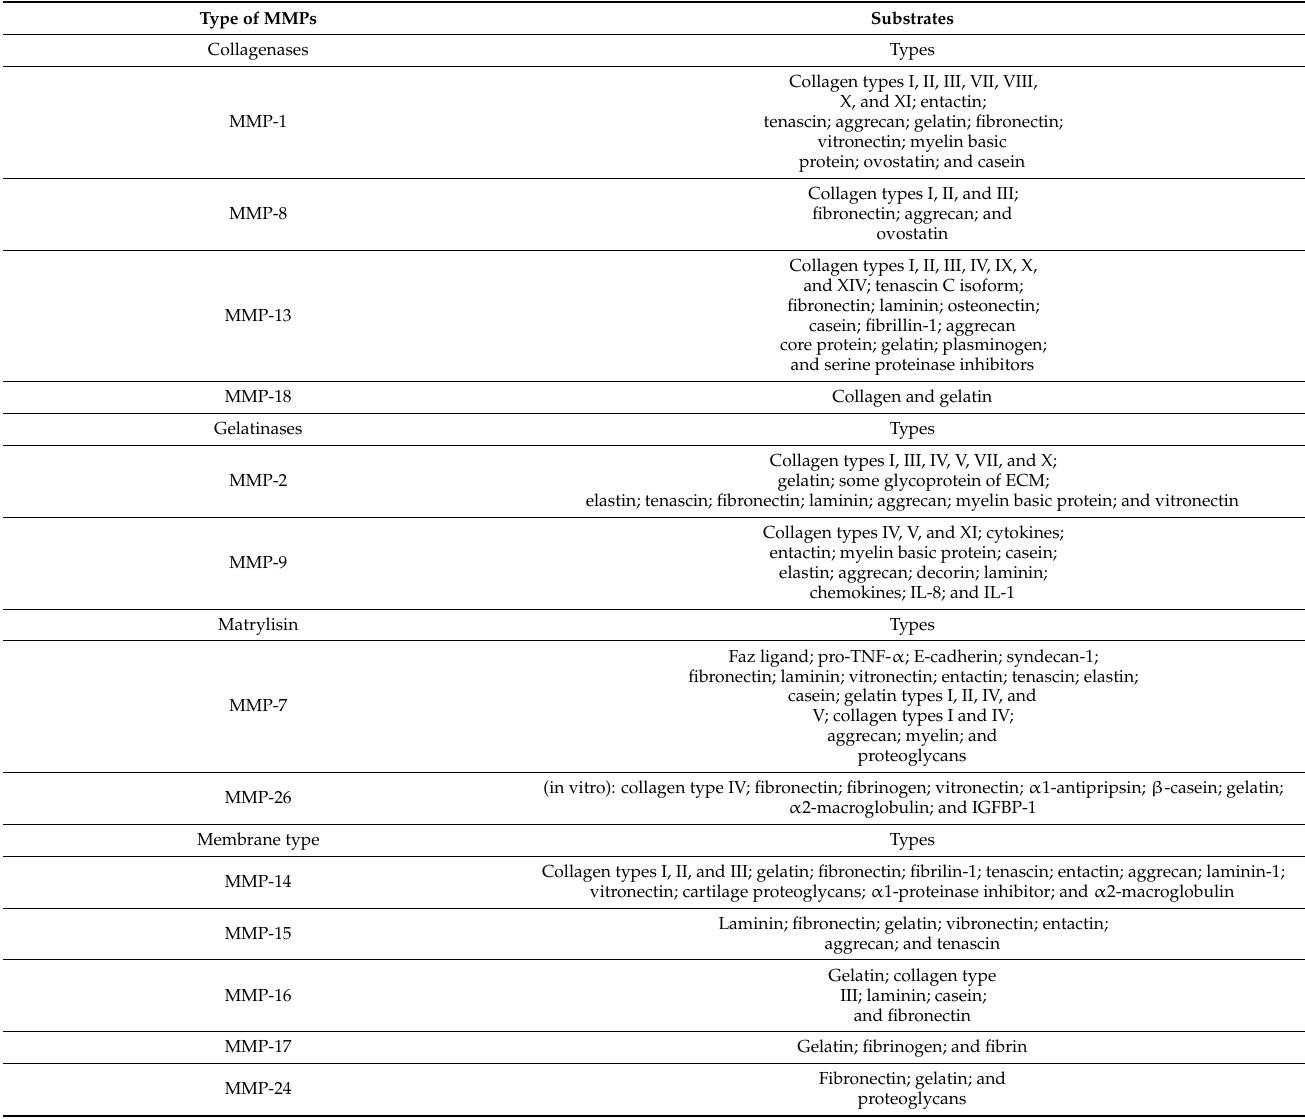
Table 2. MMP substrate specificity, domain organization, and sequential similarity classification